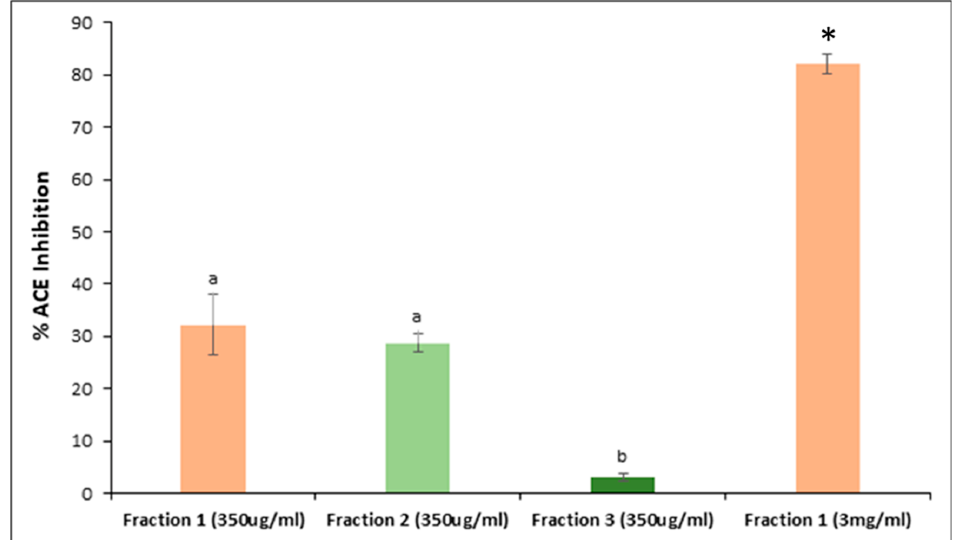
Figure 7. Antihypertensive activity (based on angiotensin converting enzyme (ACE) inhibition) of collected peptide fractions from C09052 canary seed 3K permeate following SE-HPLC separation. Different letters represent statistical difference according to the LSD method by multiple range test ( α = 0.05) with a confidence level of 95%. Values represent mean ± SD ( n = 3). * Increasing concentration to 3 mg/mL increased %ACE inhibition of fraction 1.